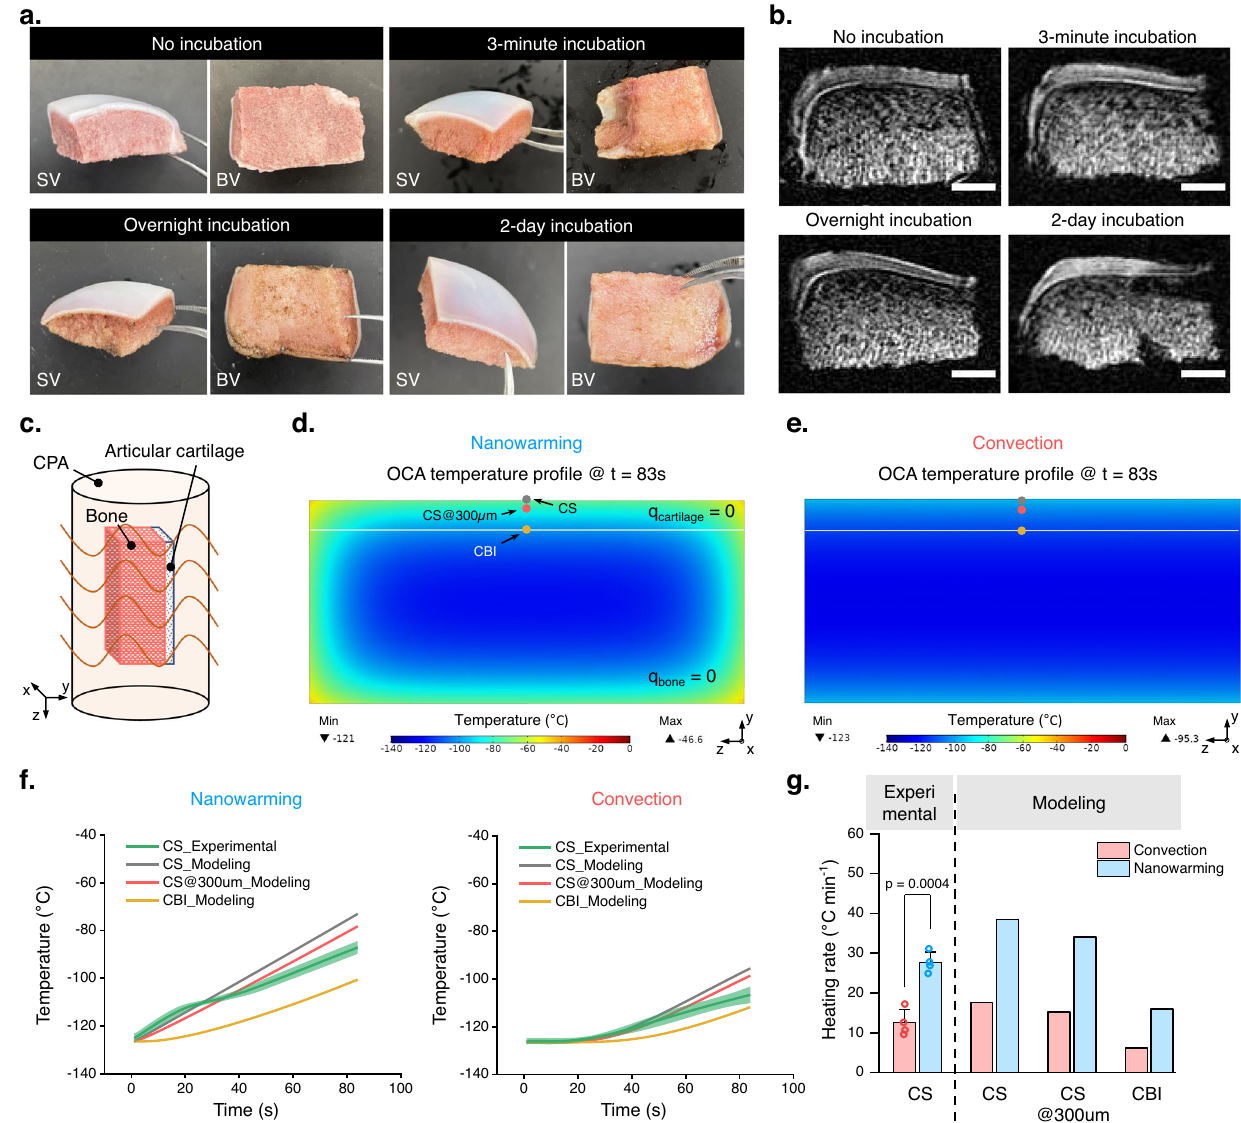
Fig. 5 Computational thermal modeling reveals depth-dependent warming pro fi le during large OCA nanowarming. a Visual inspection of OCA incubated in VS83 solutions with 2 mg ml − 1 mIONPs for 0 min (no incubation), 3 min, overnight (~12 h), and 2 days (~48 h). SV side view, BV bone-side view. b MRI scans of OCA incubated in VS83 solutions with 2 mg ml − 1 mIONPs for 0 min (no incubation), 3 min, overnight (~12 h), and 2 days (~48 h) using gradient echo sequence. Scale bars represent 4 mm. c Geometry of the OCA sample and the tube for the nanowarming computational modeling. The tube was fi lled with the CPA solutions. The tube dimensions: 14 mm in radius and 63 mm in height (~39 ml); the OCA dimensions: 20 mm in width, 30 mm in length, and 14 mm in depth (~9 ml). d Temperature pro fi le at the cross-sectional plane of the model system following 83 s of nanowarming. q cartilage and q bone are the heat generation rates in the cartilage region and bone region, respectively. The sites on the cartilage surface (CS), 300 cartilage surface (CS@300 µ m), and cartilage-bone interface (CBI) are indicated with gray, red, and yellow dots. e Temperature pro fi le at the cross- sectional plane of the modeling system following 83 s of convection warming. f Temperature pro fi le on the CS, CS@300 µ m, and CBI for both nanowarming and convection warming. The green line and light green shaded ribbon show the average temperature value collected from the experimental measurements at the cartilage surface and its standard deviation, respectively ( n = 4 independent samples). The gray, red, and yellow lines are the modeling data. g Heating rate on the CS, CS@300 µ m, and CBI derived from the temperature pro fi le presented in ( e ). Experimental data is measured from n = 4 independent samples. p -value was determined with a two-sided t -test. All data depict mean ± standard deviation. Note : mIONPs in the nanowaming group are loaded through the immersion approach for all data presented